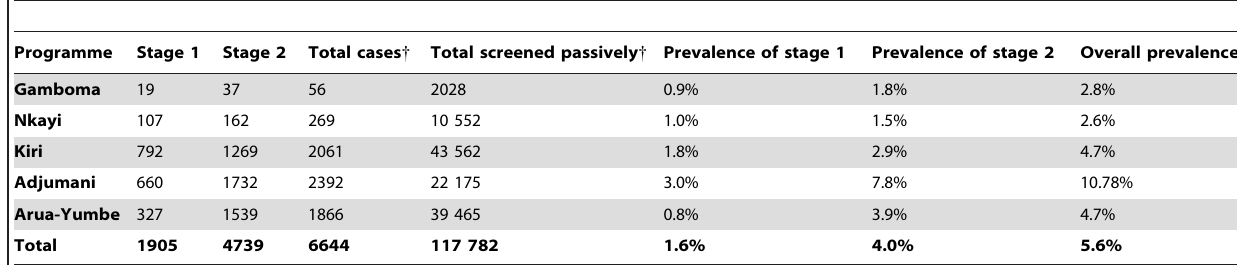
Table 7. Prevalence of stage 1 and 2 HAT infection among persons screened passively in five MSF programmes.